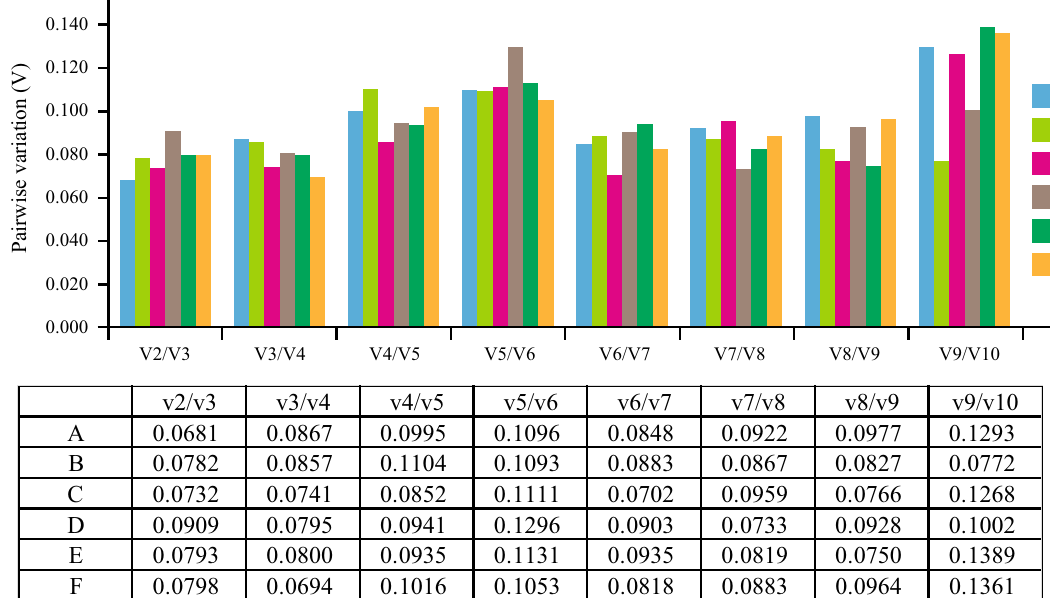
Figure 3. Optimal number of reference genes in different experimental groups calculated using geNorm. Pairwise variation (V n /V n+1 ) analysis of 10 candidate reference genes analyzed in six sample subsets. ( A ) Thirteen tissue samples derived from 1/10 MS liquid medium treatment. ( B ) Thirteen tissue samples derived from 100 mM NaCl treatment. ( C ) Thirteen tissue samples derived from 300 mM NaCl treatment. ( D ) Fifteen germinating seed samples derived from NaCl gradient treatment. ( E ) Eighteen seedling samples derived from NaCl gradient treatment. ( F ) All 72 samples used in this study.